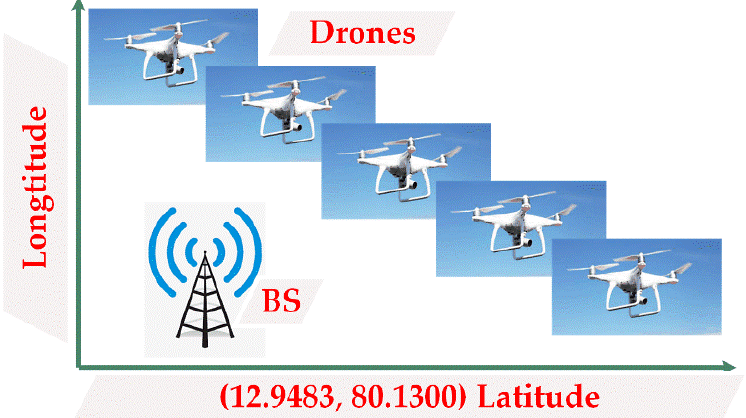
Figure 4. Initialization of drones by assuming the location of the Base station at a predetermined location. The fitness value ( B opt ) for each drone is calculated using Equation (8).